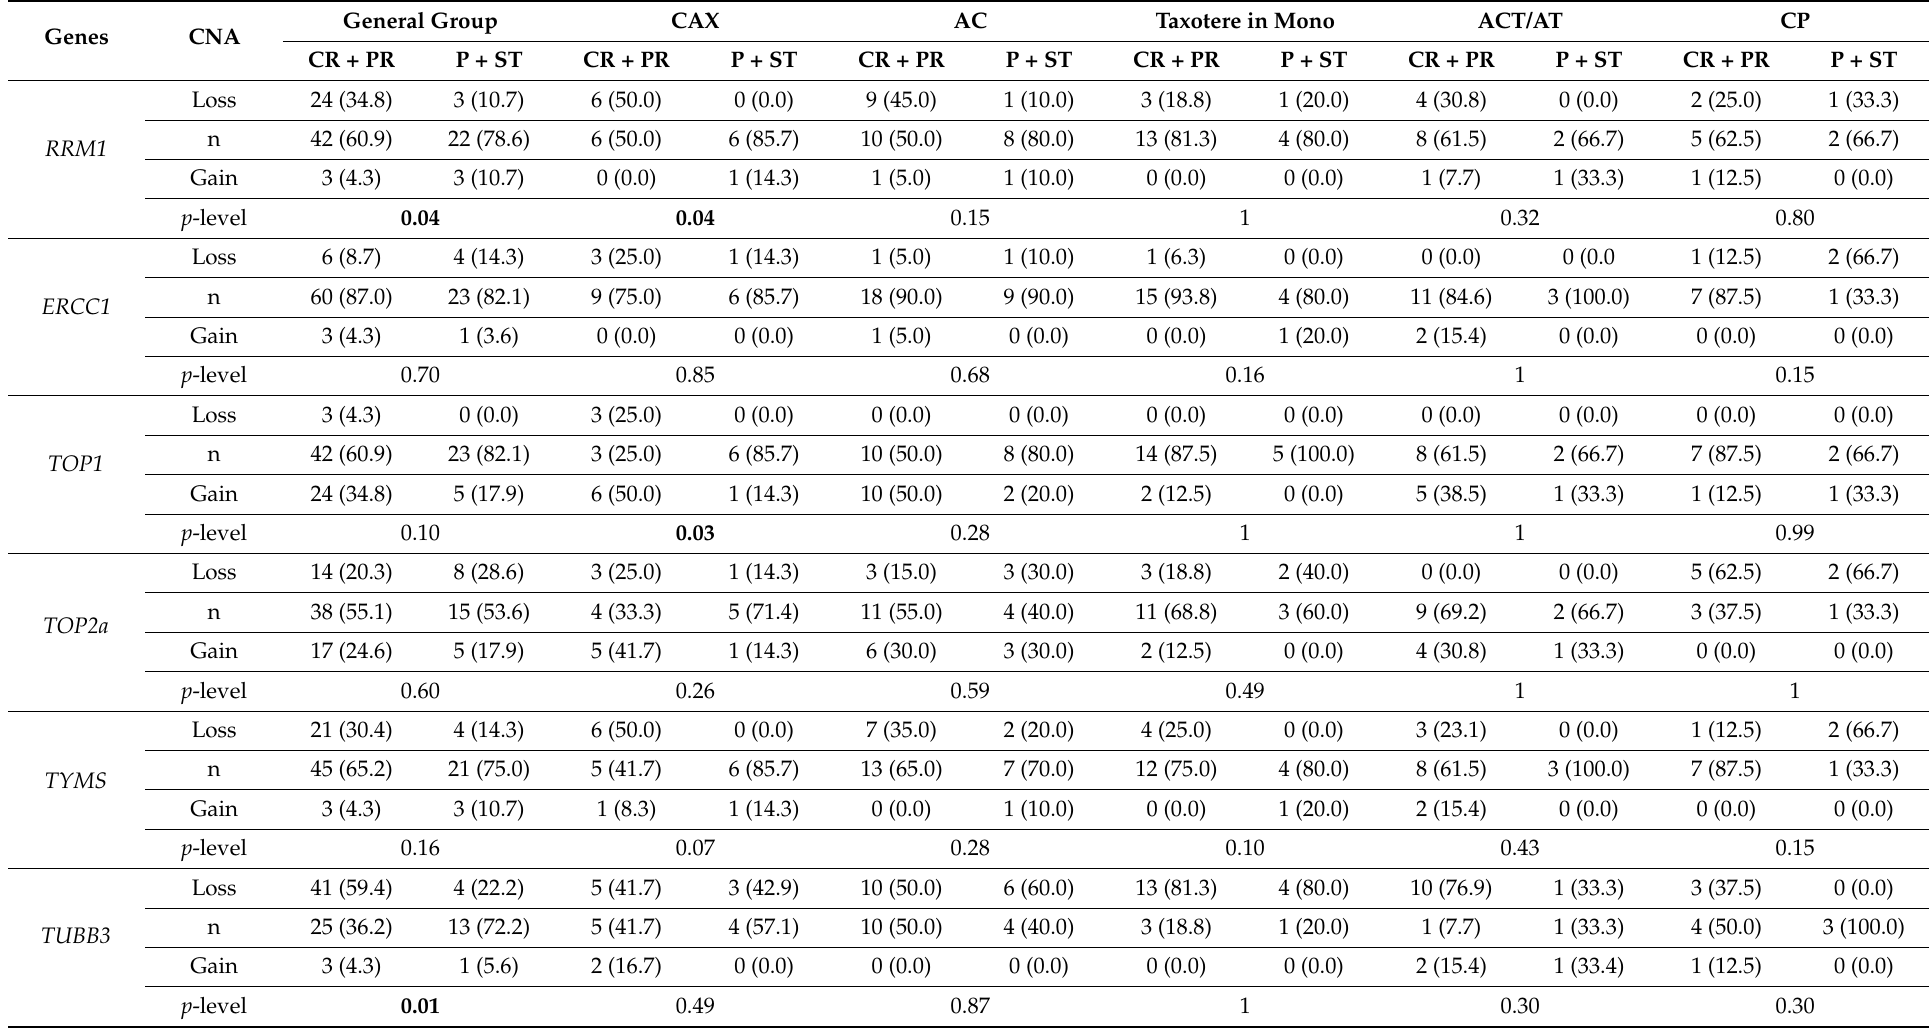
Table 3. Frequency of chromosomal aberrations in genes chemosensitivity depending on the effect and